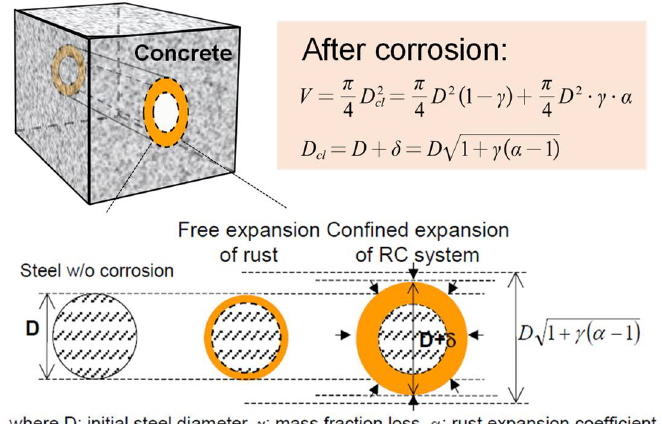
Figure 2. Mechanism of expansion and cracking of solid phase corrosion products [6].